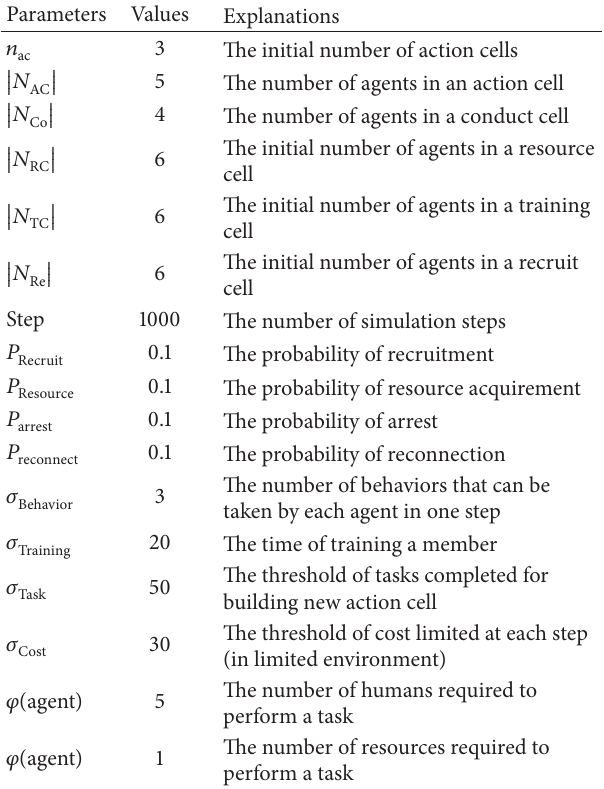
Table 3: Parameters